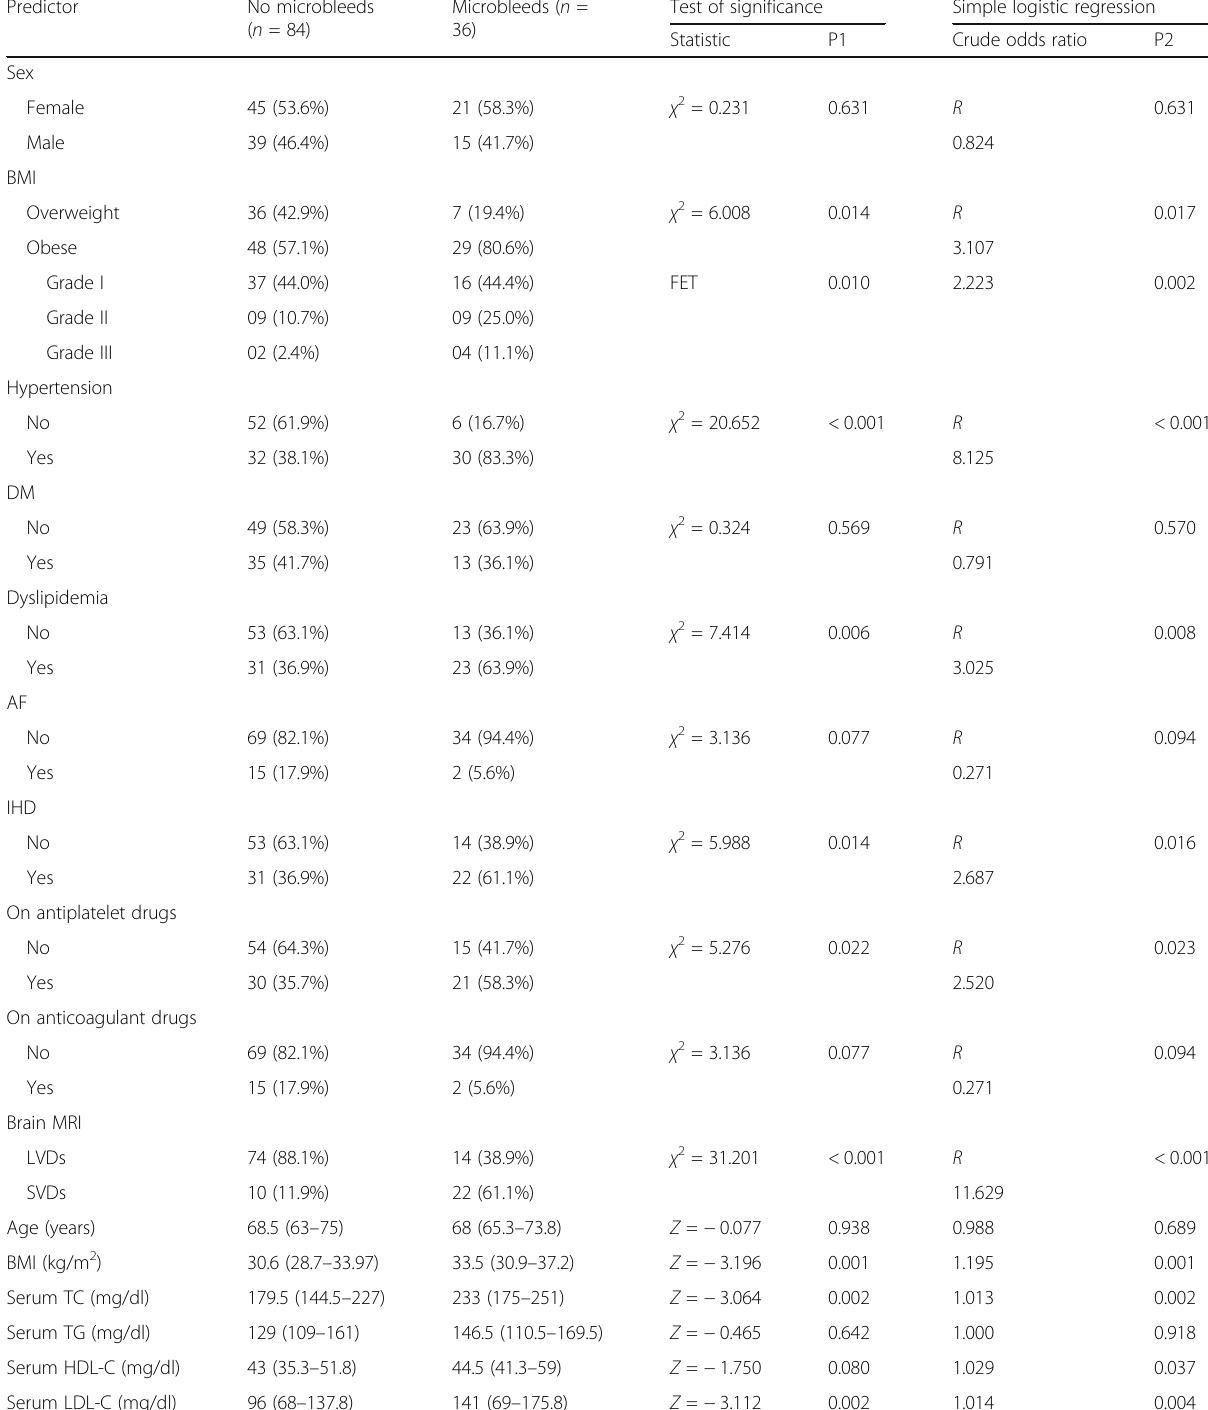
Table 3 Univariate analysis of predictors of